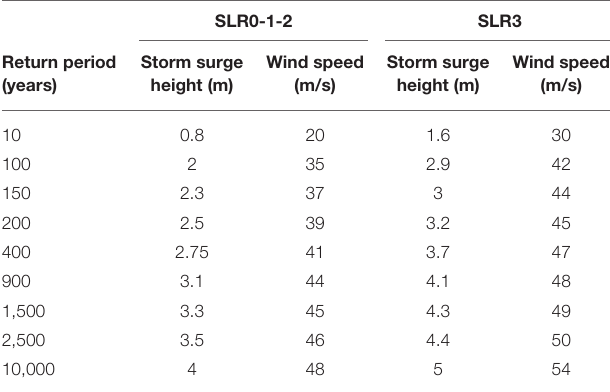
TABLE 3 | Storm surge height and wind speed for the selected return periods and sea-level rise scenarios.